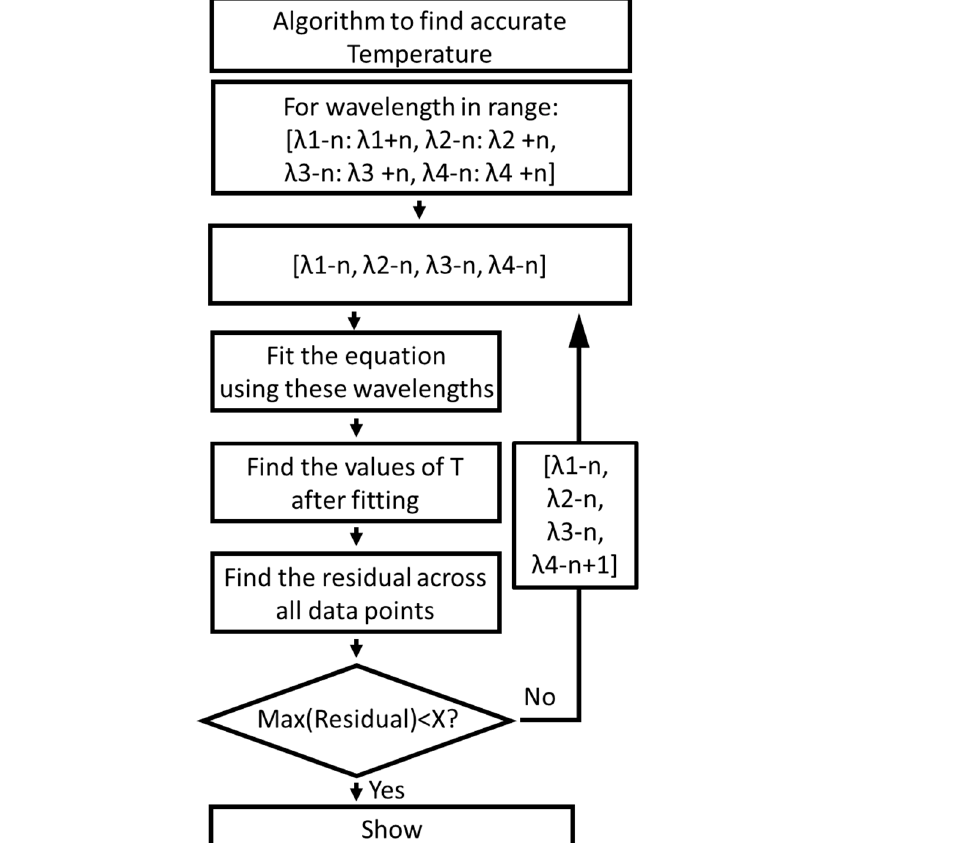
Table 2. Fitted coefficients used in Equations (4) and (5) when using the optimal wavelengths of 525, 537, 581 and 611